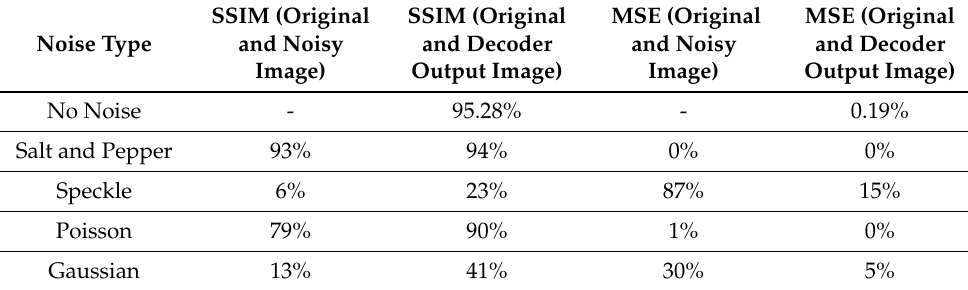
Table 6. Analysis of autoencoder effect on noisy